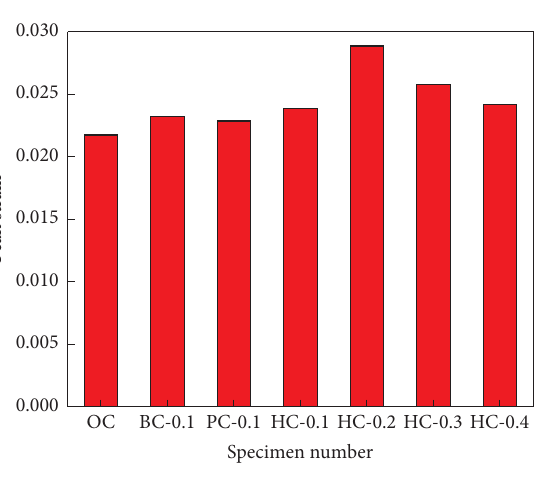
Figure 3: Peak strain.